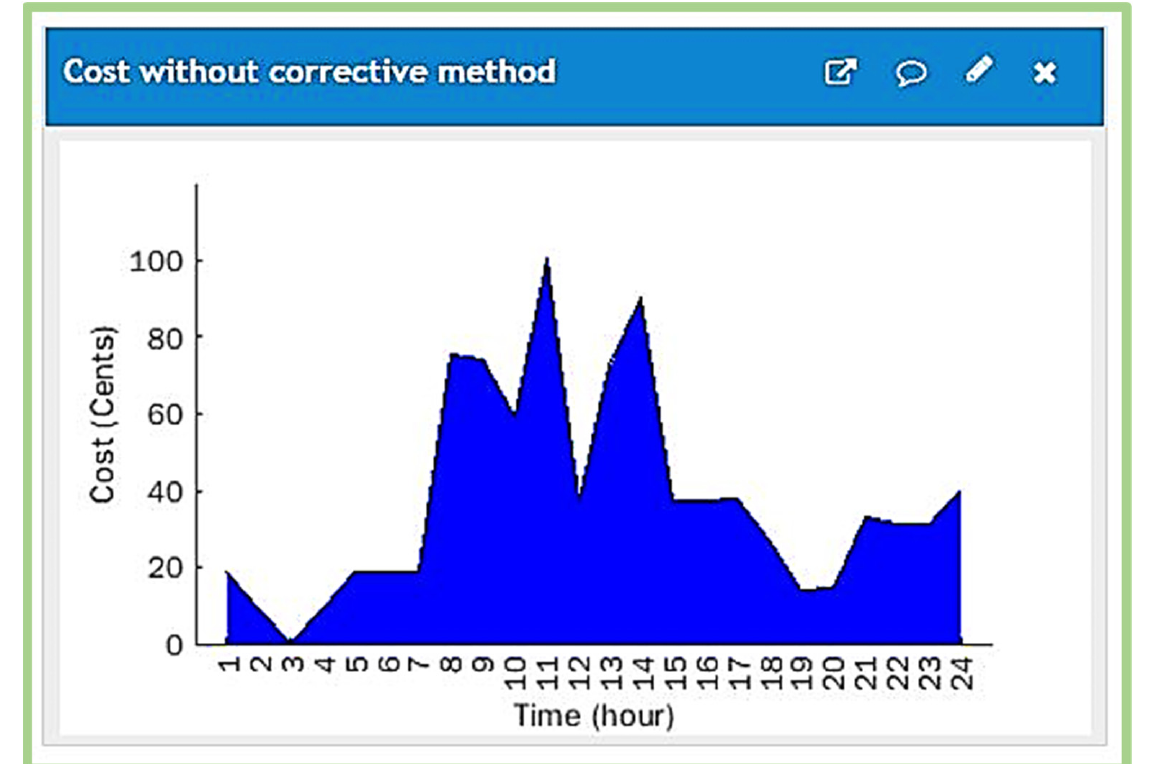
Figure 11. Cost GUI of suggested EMS without the corrective method.